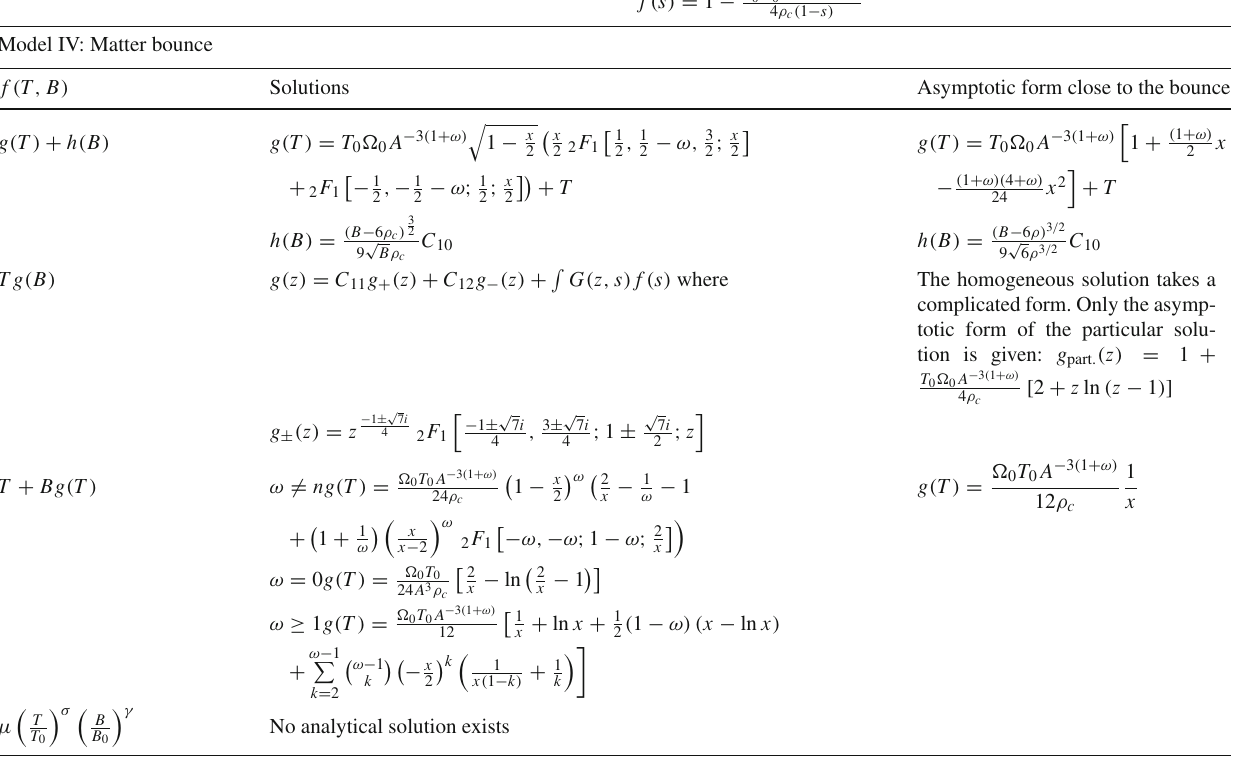
y := 12 ρ c and z := B have been defined. Here, C 10 , 11 , 12 are integra- B 6 ρ c tion constants and n ∈ N , while the Green’s function G ( z , s ) as defined (cid:13) in Eq.(B4) appearing in the Tg ( B ) model has a ( s ) = 2 s 2 ( 1 − s ) while 1 − T ρ , c